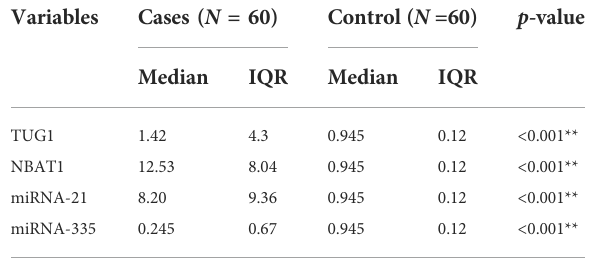
TABLE 3 The expression levels of different markers in the study groups. There was a signi fi cantly higher median of TUG1, NBAT1, and miRNA-21 among cases and a lower fold change median of